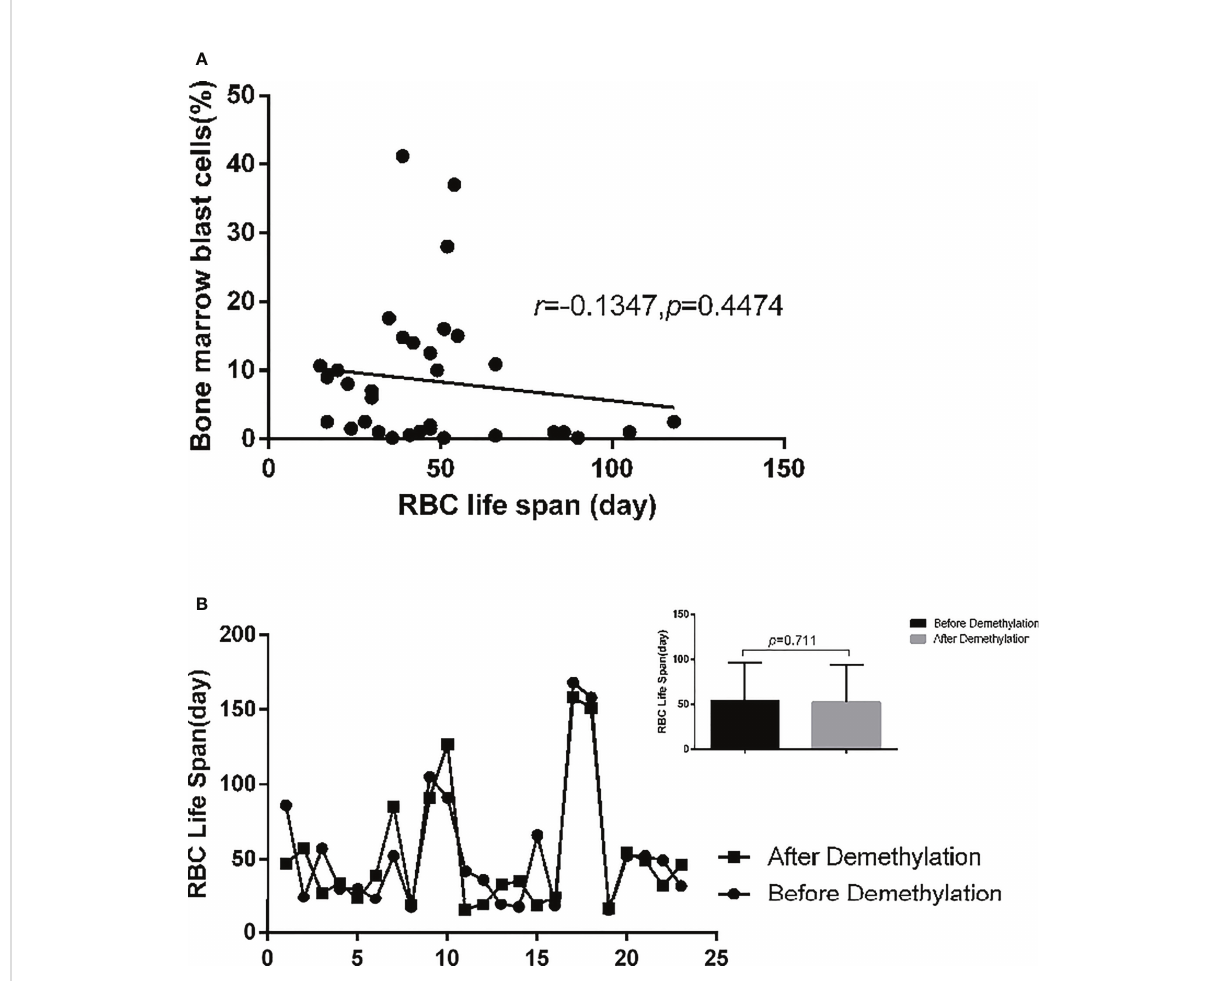
FIGURE 6 34 high-risk MDS and tAML patients(except 6 patients who underwent allogeneic stem cell transplantation) were included in the analysis. (A) There was no signi fi cant correlation between the number of bone marrow primordial cells and RBC life span ( r =-0.1347, p =0.4474). (B) 23 patients with medium and high-risk MDS patients were detected RBC life span before and after demethylation drug treatment. It shows that demethylation treatment has no signi fi cant effect on the RBC life span ( p